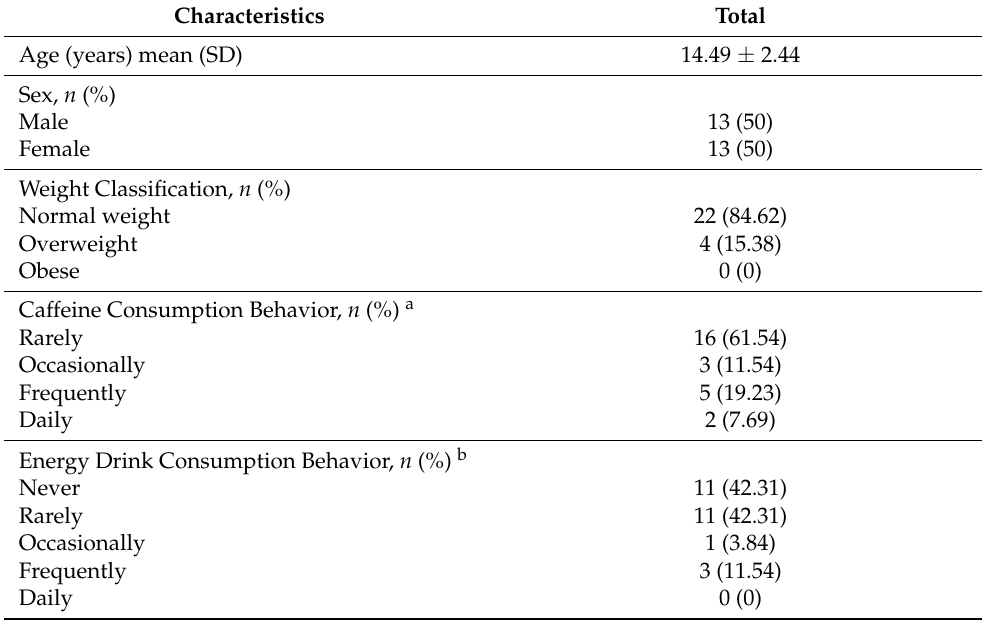
Table 1. Study participants’ characteristics ( n = 26).